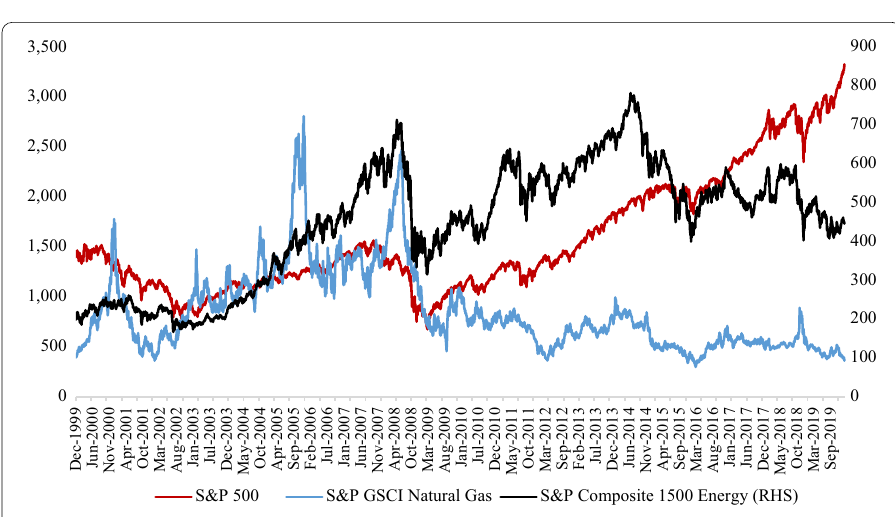
Fig. 3 Performance of S&P 1500 Energy, S&P 500, and Natural Gas. Note : Displayed on the left side of this figure is the performance of S&P 500 index, while on the right side are those of S&P Composite 1500 Energy and S&P GSCI Natural gas market indices. The period covered is from December 1999 to July 2019. Source : S&P 500 Dow Jones Indices,